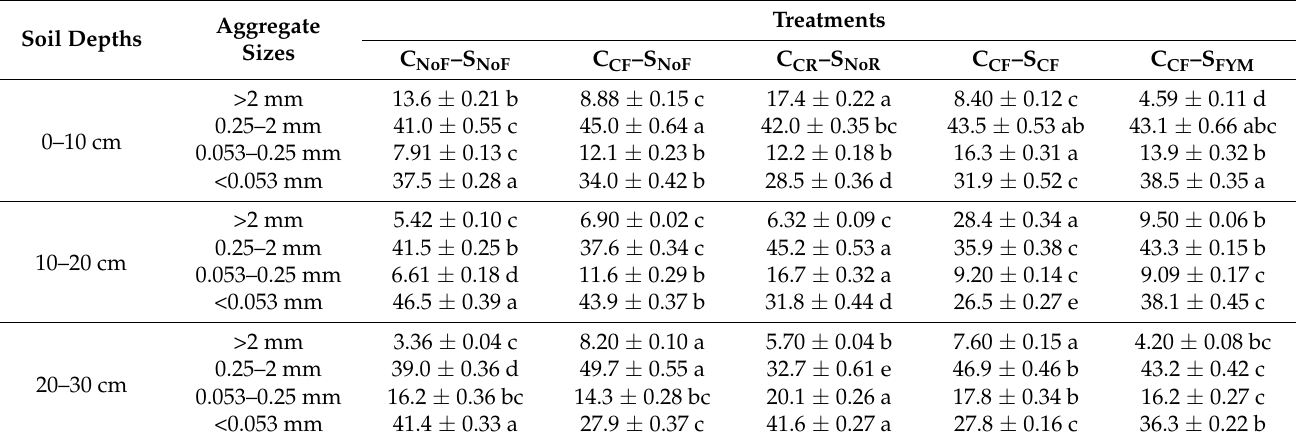
Table 2. Size distribution proportion (%) of water–stable